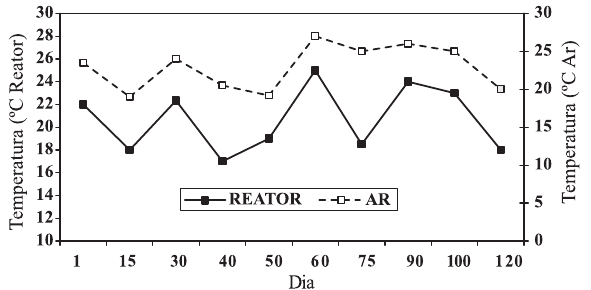
figura 3. evolução da temperatura do solo e do ar durante a biorremediação.